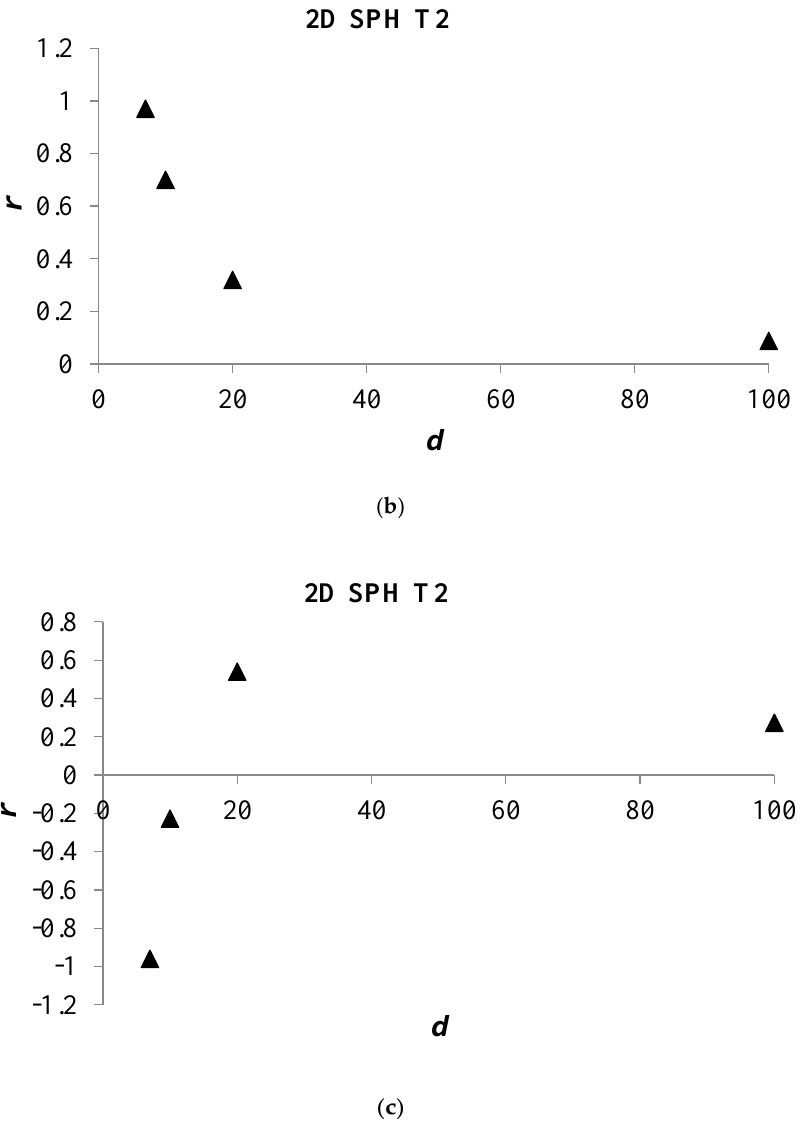
Figure 25. Plot of r versus d for: ( a ) (p–u); ( b ) ( p–v ); and ( c ) ( u–v ) pairs of data (configuration: T2).